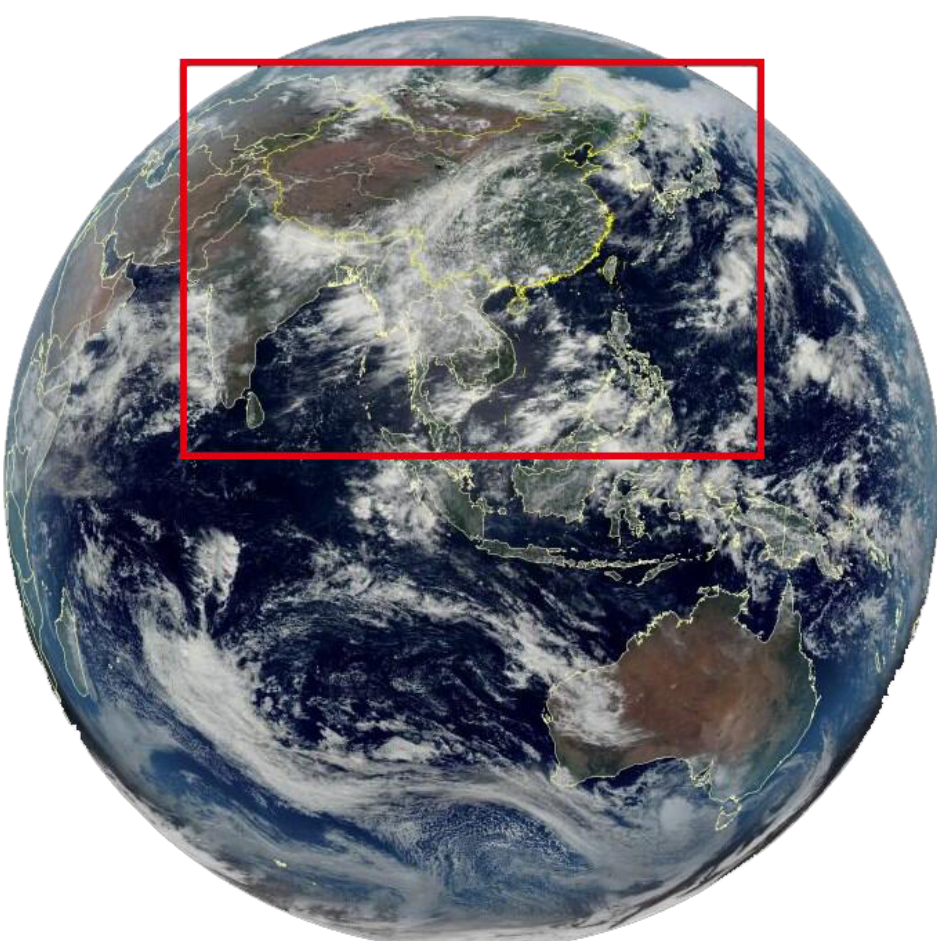
Figure 1. REGC range from the FY4A AGRI 105 ◦ scan (marked within the rectangle